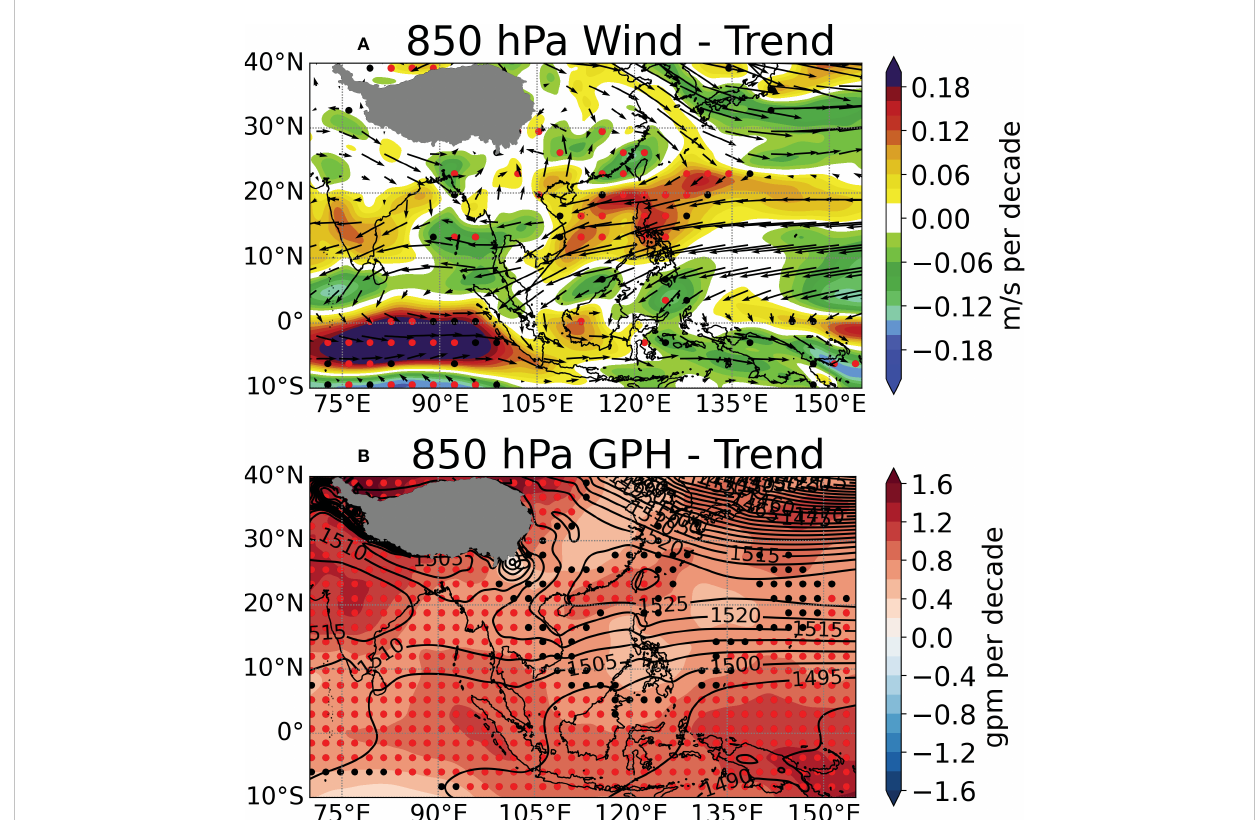
FIGURE 7 Seasonal mean (vectors and black contours) and climatic trends (shaded) for the AR-associated large-scale environments in AR Days for autumn- winter seasons during the period 1951 – 2015, including 850-hPa wind fi eld (unit: m s -1 ) (A) , 850-hPa geopotential height (contour, unit: gpm) (B) . Red (black) stippling indicates statistically signi fi cant trends with con fi dence levels above 95% (90%). Grey-shaded areas in (A) and (B) mask out contours inside the Tibetan